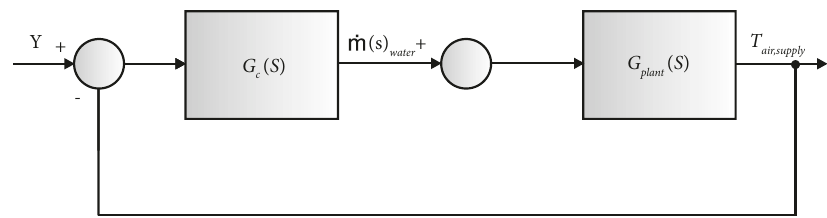
Figure 3: PID block